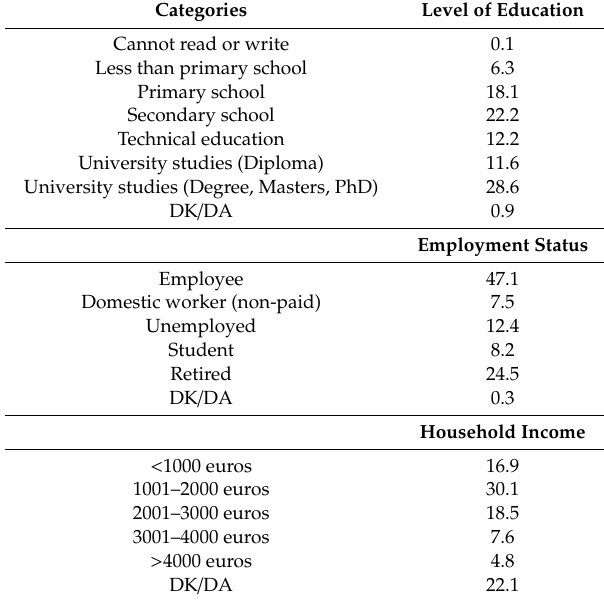
Table 1. Percentage of surveyed population according to level of education, employment status, and household